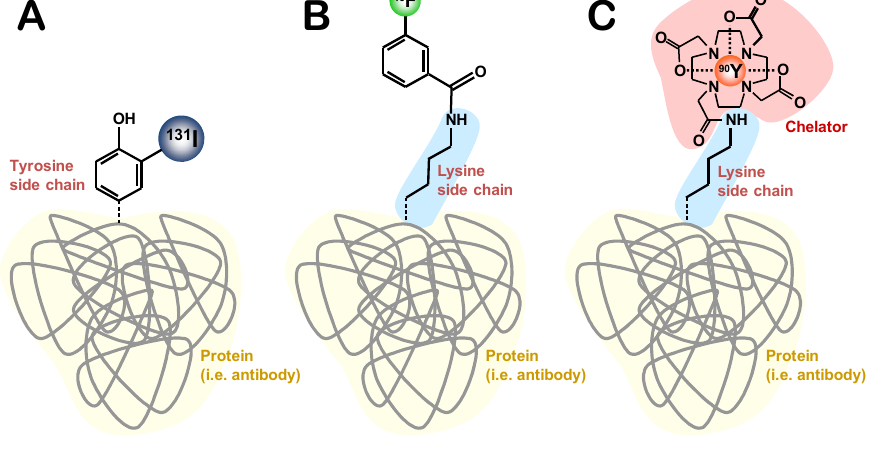
Figure 2. Illustration of the three main strategies for the radiolabeling of proteins. ( A ) direct labeling ( B ) indirect labeling via a prostetic group and ( C ) indirect labeling via a protein: ( A ) iodine ( B ) fluorine and ( C ) metallic radionuclides. Maleimides and